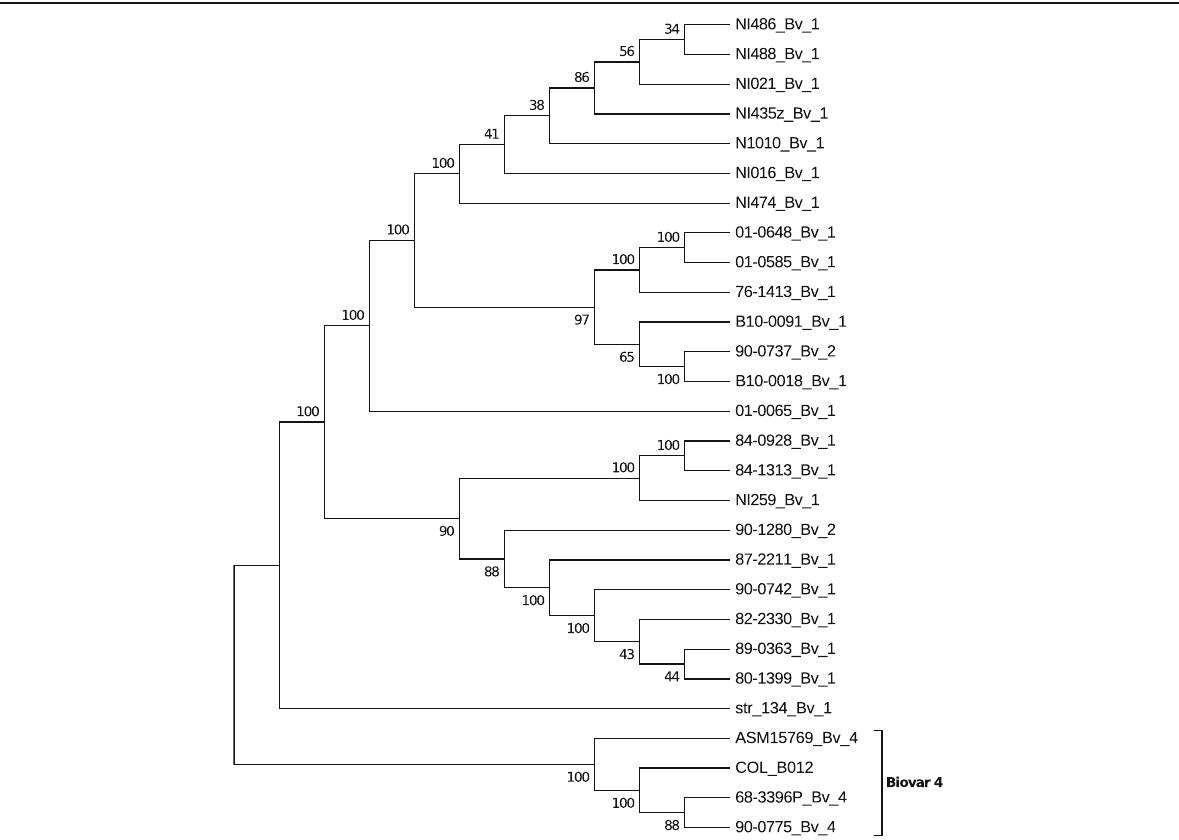
Fig. 2 Evolutionary relationships of B. abortus strain Ba Col-B012. The evolutionary history was inferred using the Neighbor-Joining method [33]. The bootstrap consensus tree inferred from 1000 replicates [34] is taken to represent the evolutionary history of the taxa analyzed [35]. All positions containing gaps and missing data were eliminated. There were a total of 2,632,124 positions in the final dataset. Evolutionary analyses were conducted in MEGA6